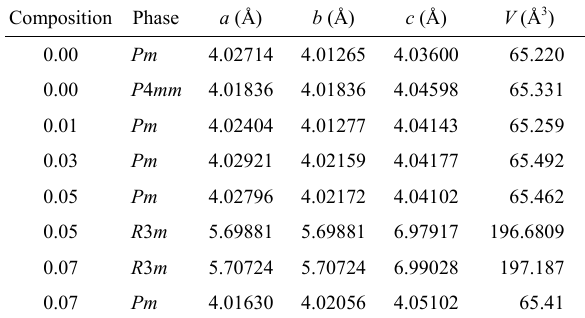
Table 1 Lattice parameters of PMN–PT– x BNZ ceramics